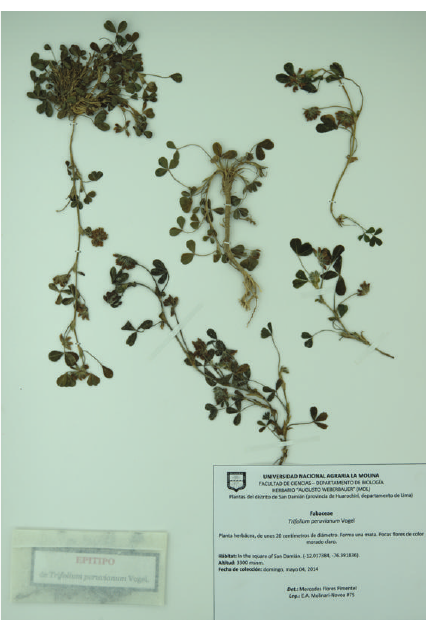
Figure 1: Molinari-Novoa 75 : epitype of Trifolium peruvianum Vogel.